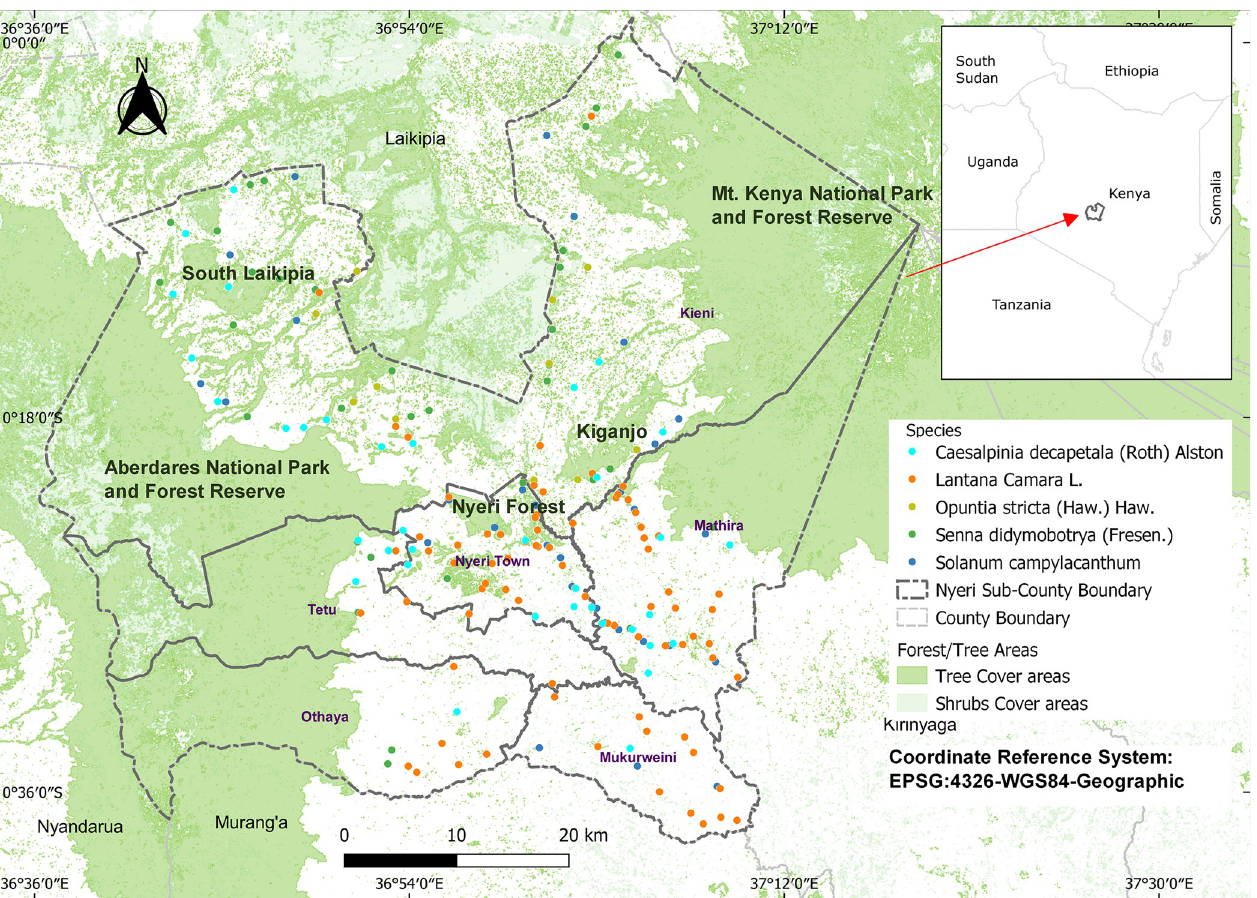
Fig 1. Study area map showing distribution of invasive species occurrence records. Data sources: (Administrative boundary layer: GADM database (www. gadm.org) under CC BY 4.0 license (https://gadm.org/license.html); Species presence data: GBIF.org (https://doi.org/10.15468/dl.v2peyj) and own roadside survey field work in Nyeri County under CC BY 4.0 license; Forest/tree cover layer: SERVIR GLOBAL data catalog [32] (https://servirglobal.net/Data-and- Maps) under CC BY 4.0 license.